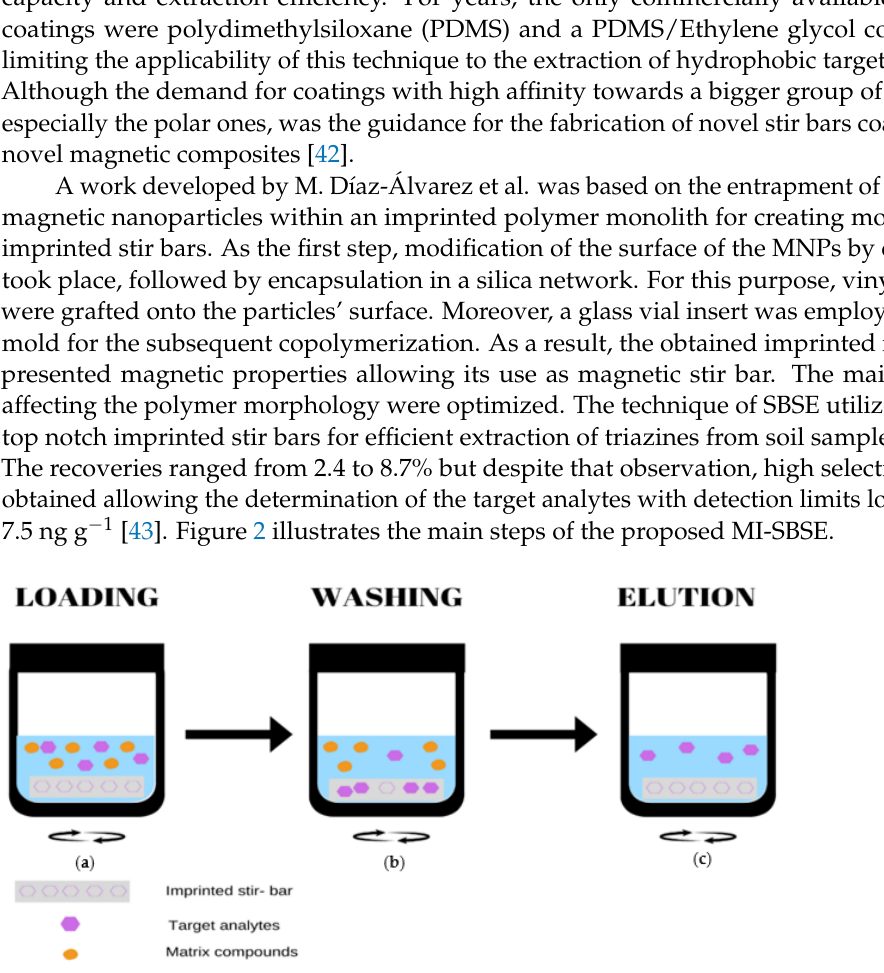
Figure 2. Scheme of the proposed MI-SBSE. ( a ) Matrix compounds—orange; ( b ) Target analyte— purple; ( c ) Imprinted stir bar—grey.